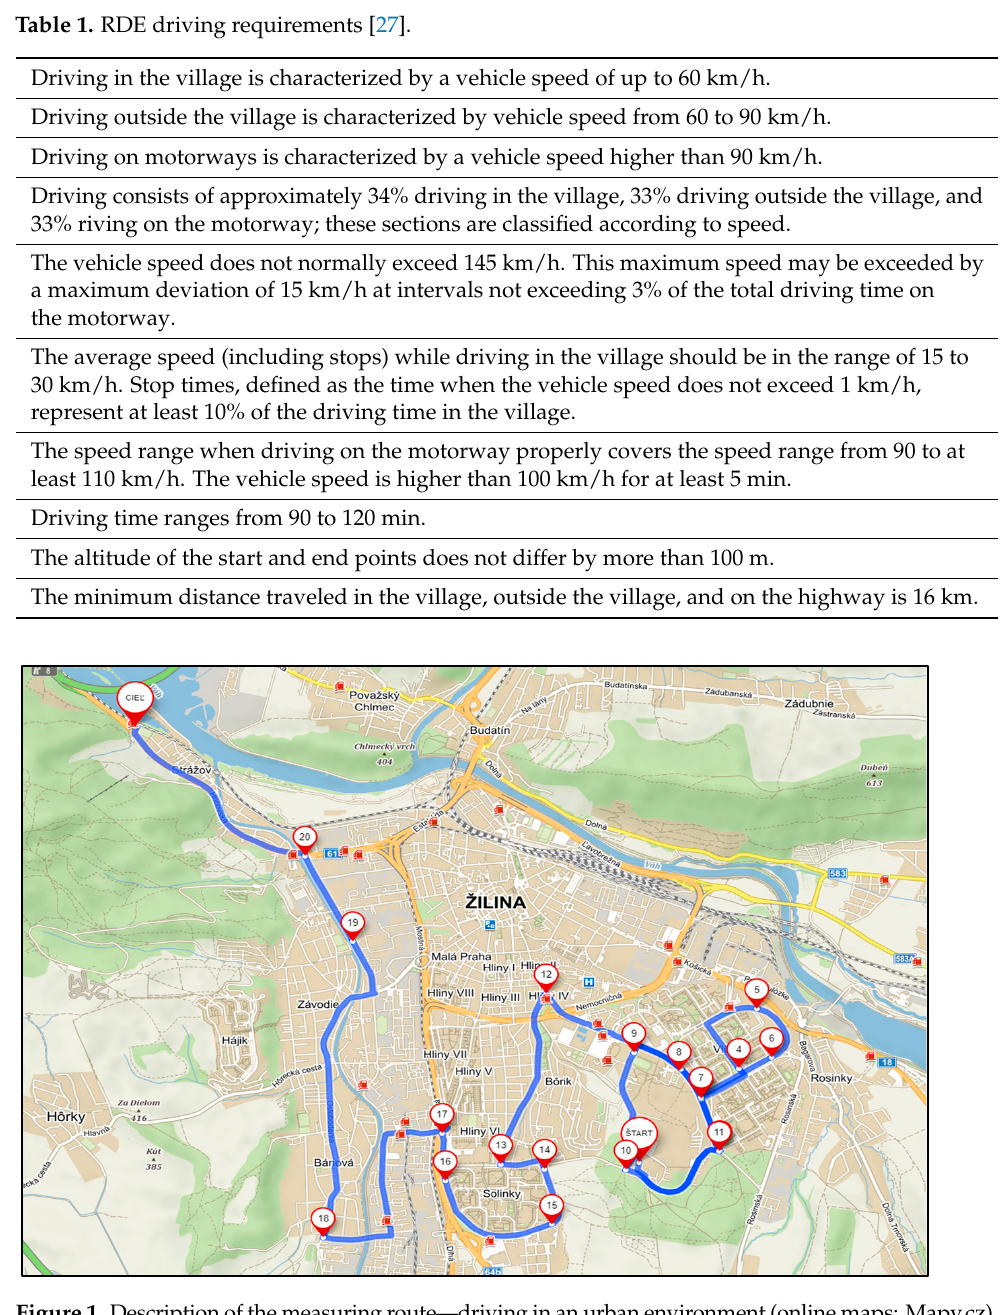
Figure 1. Description of the measuring route—driving in an urban environment (online maps: